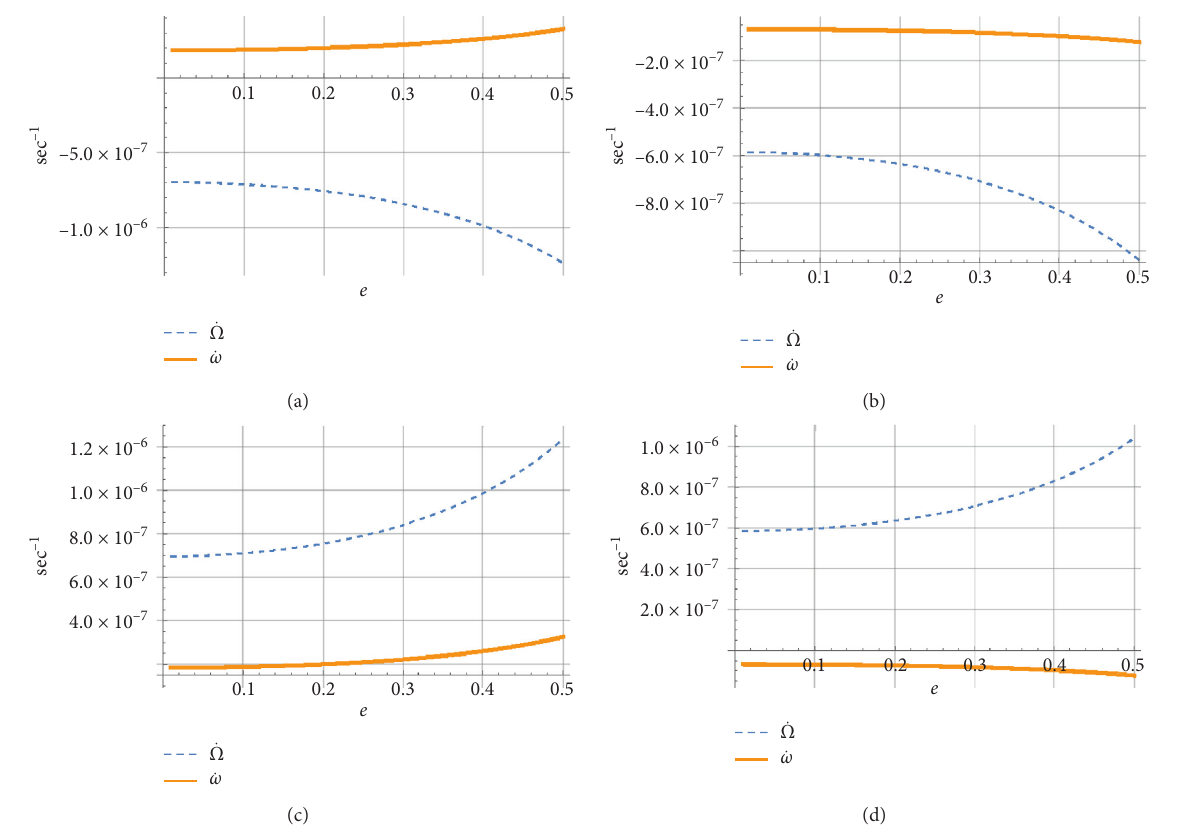
Figure 8: Curves of _ Ω and _ ω with e for the 4 cases corresponding to F ( i ) � 0.1. (a) i � − 59 . 76, (b) i � 64 . 84, (c) i � − 120 . 24, and (d) i � 115 .